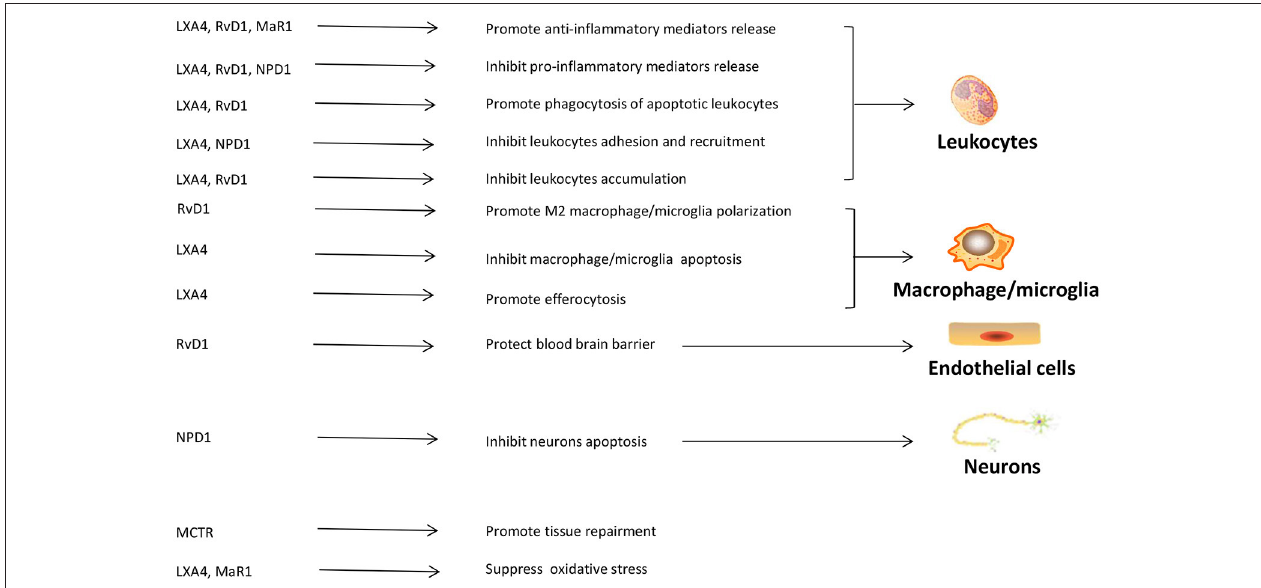
FIGURE 2 | The roles of SPMs in cerebral ischemia reperfusion injury. SPMs can display their protective roles through interacting with leukocytes, macrophages/microglia, vascular endothelial cells, and neurons in cerebral ischemic reperfusion injury. The main functions of SPMs in cerebra ischemic reperfusion injury include regulating leukocytes adhesion, infiltration and apoptosis, mediating inflammatory mediators release, adjusting macrophages/microglia polarization, protecting blood brain barrier, inhibiting neuronal apoptosis, promoting tissue restitution, suppressing oxidative stress. LXA4, lipoxin A4; RvD1, resolving D1; MaR1, maresin1; NPD1, protectin D1; MCTR, maresin conjugates in tissue